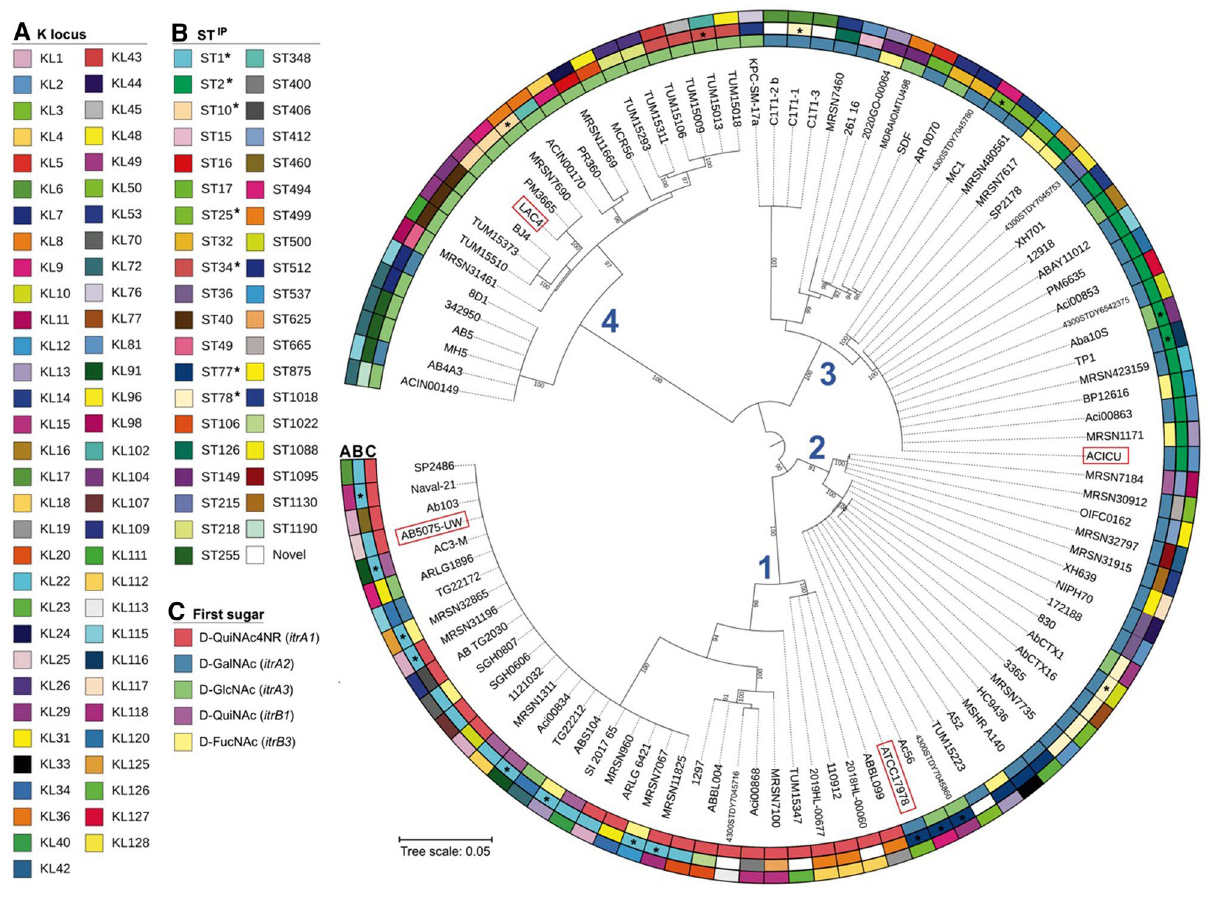
Figure 5. Phylogeny of wzi sequences in a diverse collection of A. baumannii genomes. Strain names are shown. Surrounding rings indicate the K locus type (ring A), Institut Pasteur sequence type (ST IP , ring B), and predicted or known first sugar of the CPS unit produced by the respective KL genes (ring C), and colour scheme is shown on the left. Blue numbers (1–4) indicate major phylogenetic clades. * denotes single locus variants (SLV) of sequence